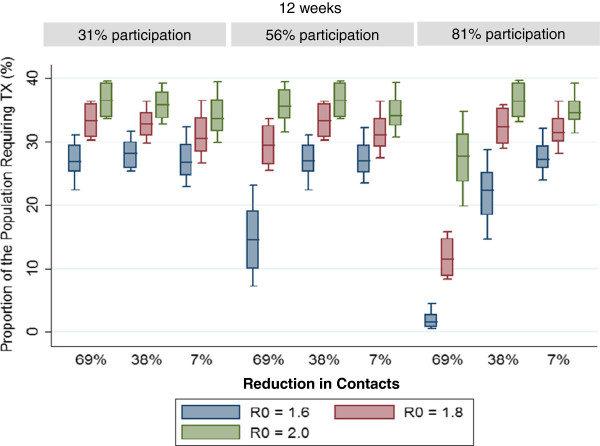
The median (line within the shaded box), 25th and 75th percentile values (top and bottom of shaded box), and upper and lower adjacent values (error bars) proportion of the Canadian population expected to require antiviral treatment (Y-axis) during a severe pandemic as a function of viral transmissibility and the magnitude of change maintained for 12 weeks. Each box represents 9 individual simulation runs using a range of pre-existing immunity values from 0-40%. We examined three different levels of behaviour change uptake where between 31% and 81% of the Canadian population engages in social distancing behaviour. The magnitude of the behaviour change ranged from only a 7% reduction in contacts to a 69% reduction in contacts for all scenarios.